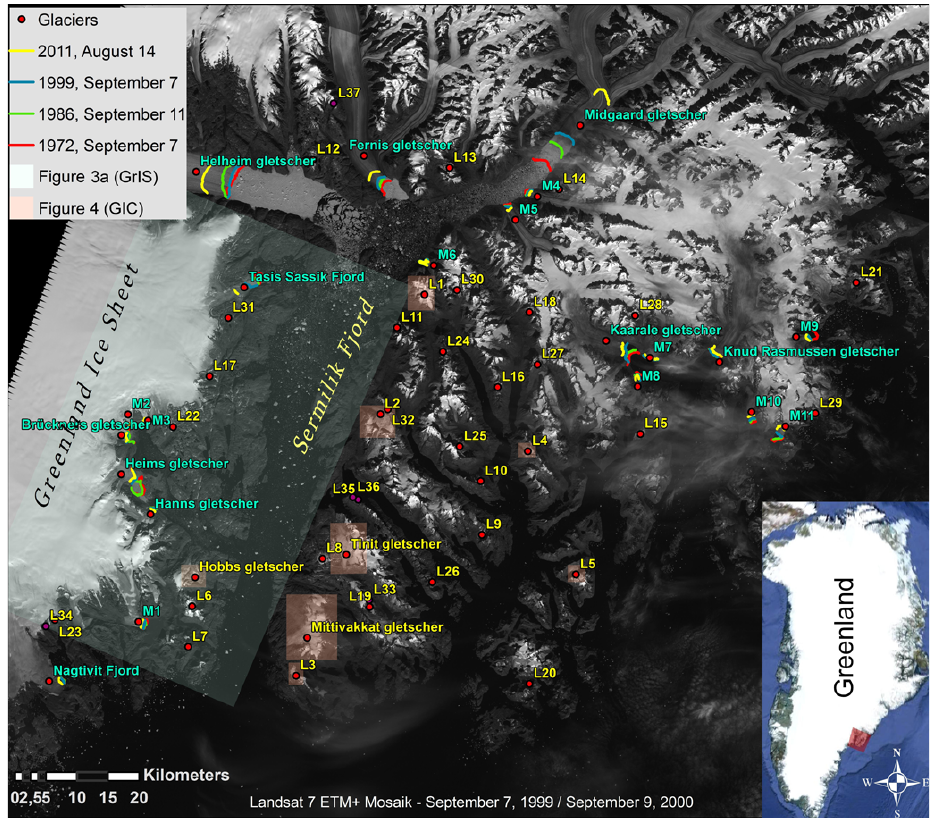
Fig. 1. The Ammassalik region, including the Sermilik Fjord and parts of the southeastern sector of the GrIS. The marine-terminating glacier margins are marked with positions (lines) for each of the survey years: 1972 (red color), 1986 (green), 1999 (blue), and 2011 (yellow) (the location names are written in turquoise). The 35 local land-terminating glaciers and ice caps (GIC) peripheral to the GrIS are written in yellow, where eight are marked with shaded areas; marginal changes for those eight GIC and the GrIS are illustrated in detail. The GIC marked with L33–L37 are examples of GIC that melted away during 1986–2011. The inset figure indicates the general location of the Ammassalik region in Southeast Greenland (source: Landsat 7 ETM+ Mosaik, 7 September 1999/9 September